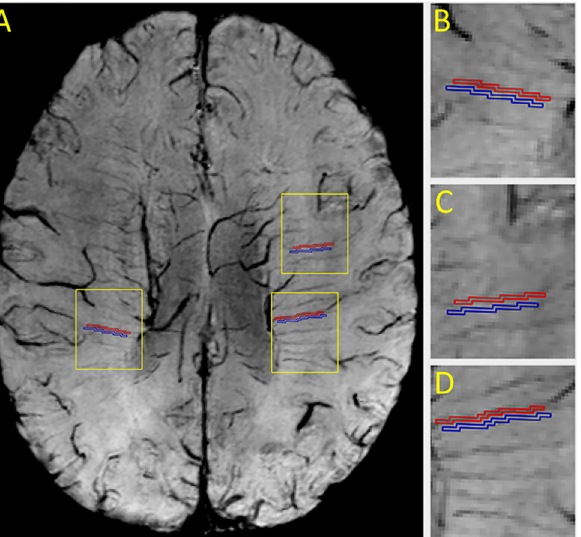
Fig 1. Description of contrast-to-noise ratio (CNR) measurement for deep medullary veins (DMV) in a combined multi-echo susceptibility weighted image. A, Each red region of interest (ROI) for periventricular DMV was drawn with one pixel width along the center of vein. Each blue ROI for neighboring white matter tissues was drawn surrounding the vein by the same pixel size of red ROI. Three different regions of DMV and adjacent white matter tissues (yellow rectangle in A) were shown (B to D, magnification of the three regions in A). CNR was calculated based on values obtained from the two